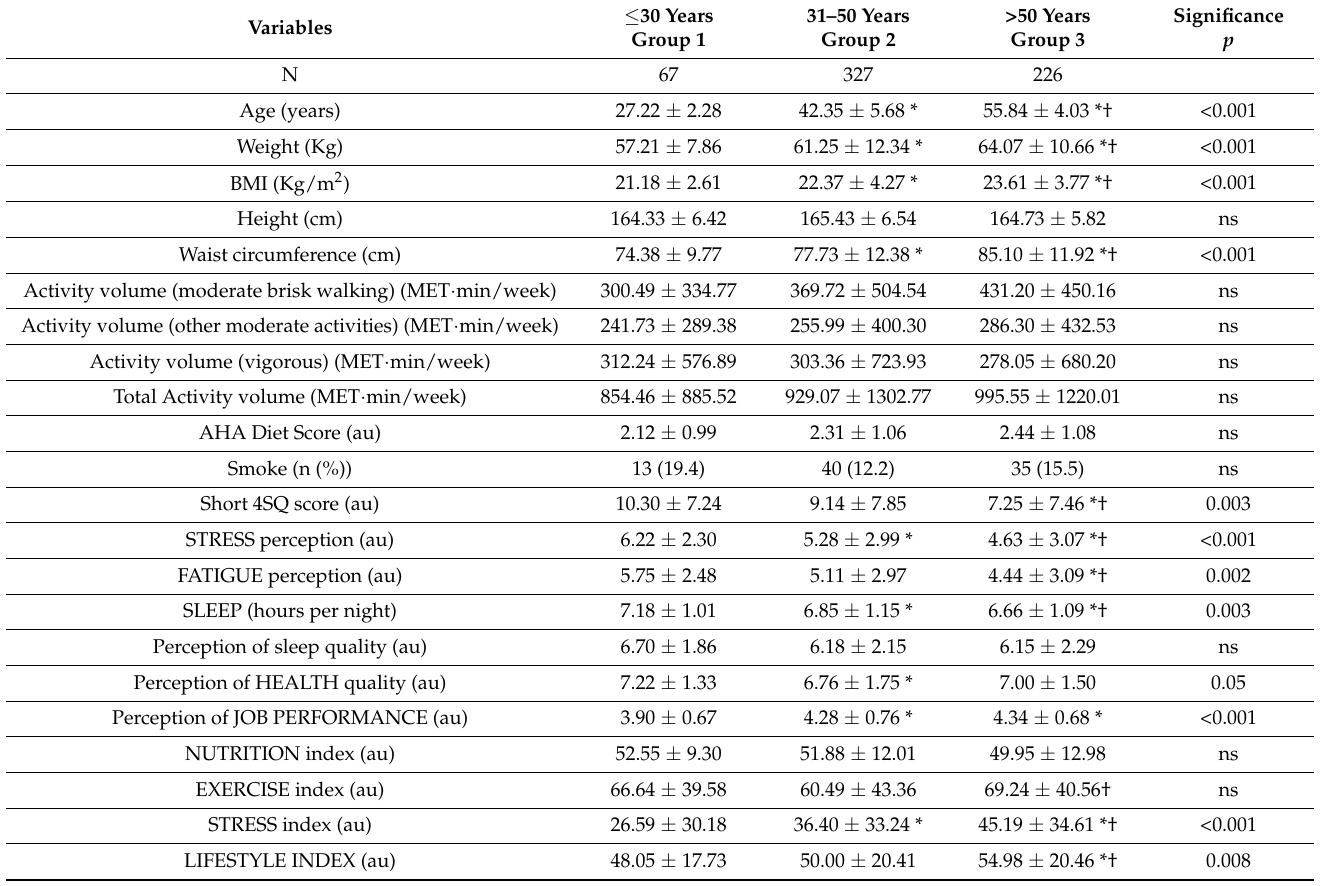
Table 2. Anthropometric and lifestyle data were collected in women by separately considering the three age